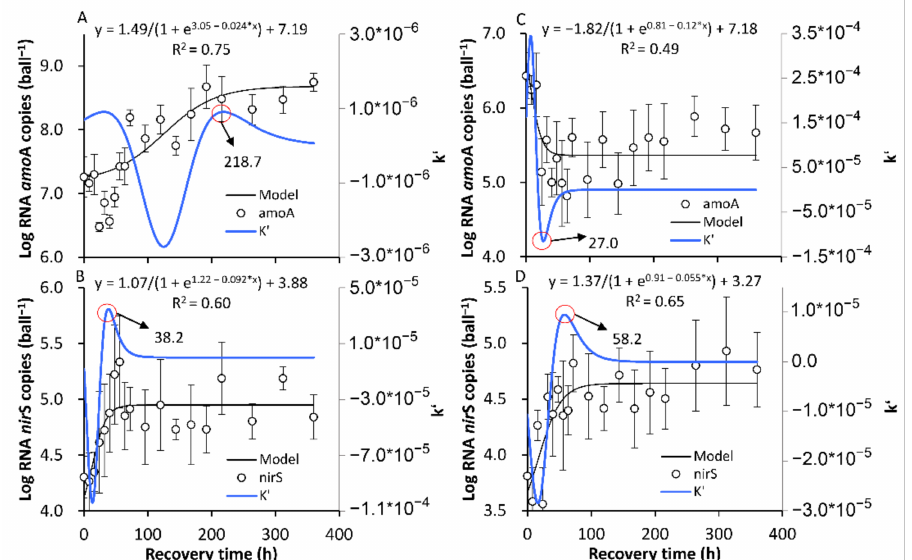
Figure 11. The recovery of the original stable state (SS) of the RNA level abundance of nitrogen-cycle functional genes amo A and nir S after the seven-day aeration or no aeration interruption. ( A , B ) show the recovery of the original SS of the RNA level abundances of amo A and nir S, respectively, in the AE-D reactors; ( C , D ) show the recovery of the original SS of the RNA level abundances of amo A and nir S, respectively, in the AN-D reactors (sample number: